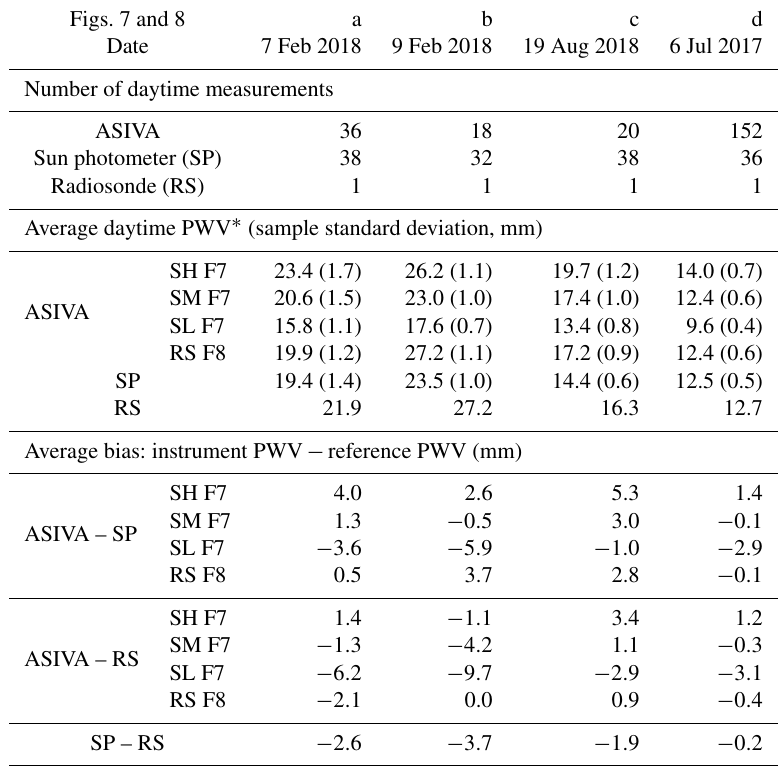
Table 2. ASIVA, sun photometer, and radiosonde PWV retrieval statistics for the cases shown in Figs. 7 and 8. Figs. 7 and 8 a b c